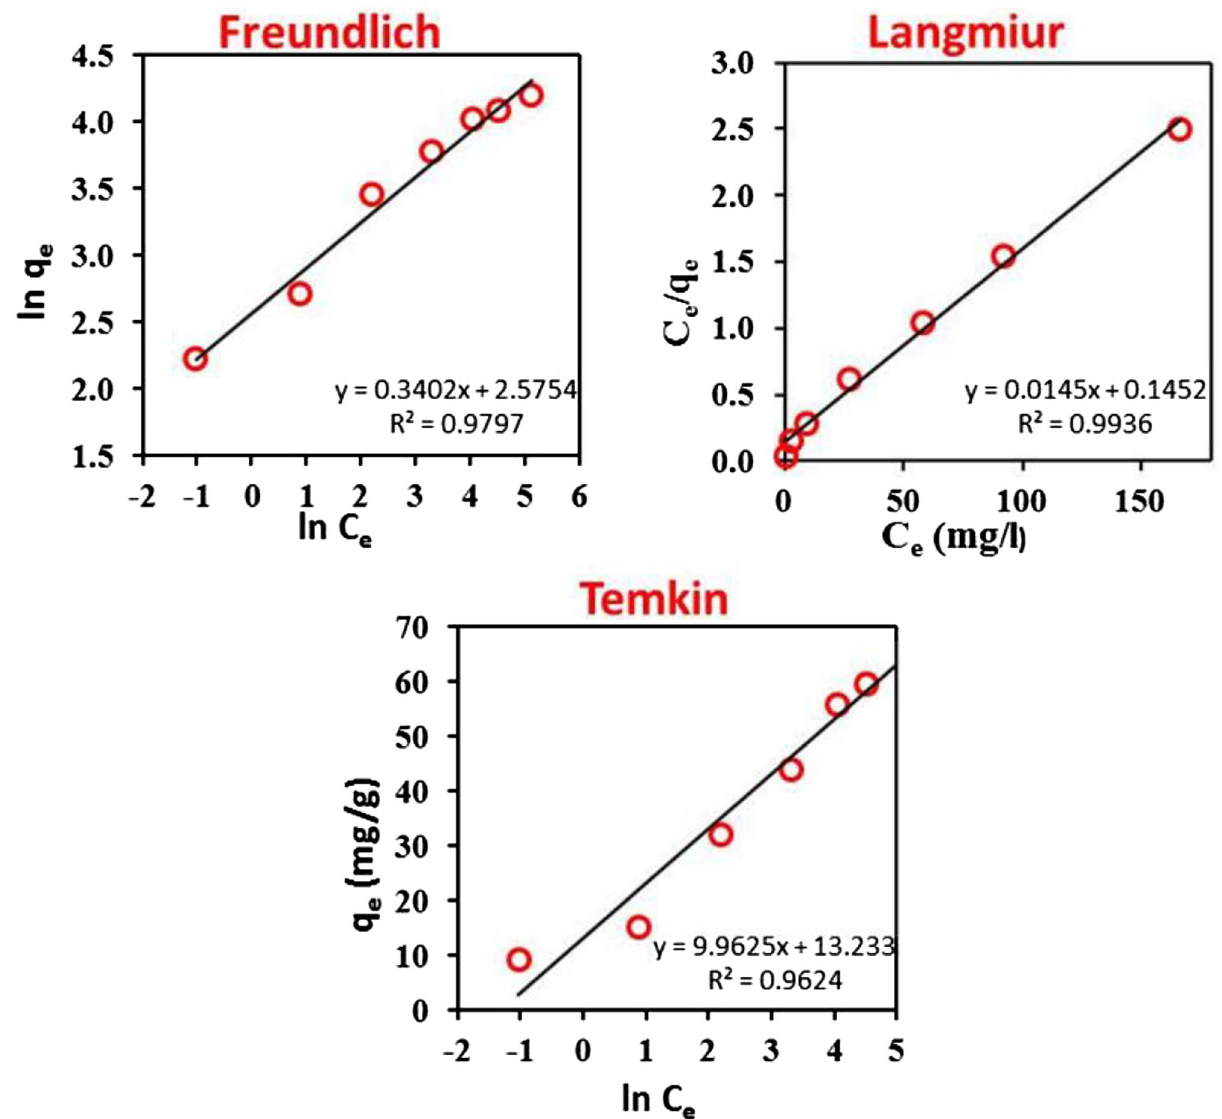
Figure 4. Models for equilibrium isotherms for the biosorption of MB onto the biomass of P. alcaliphila NEWG-2 bio-sorbent material include Langmuir, Freundlich, and Temkin.